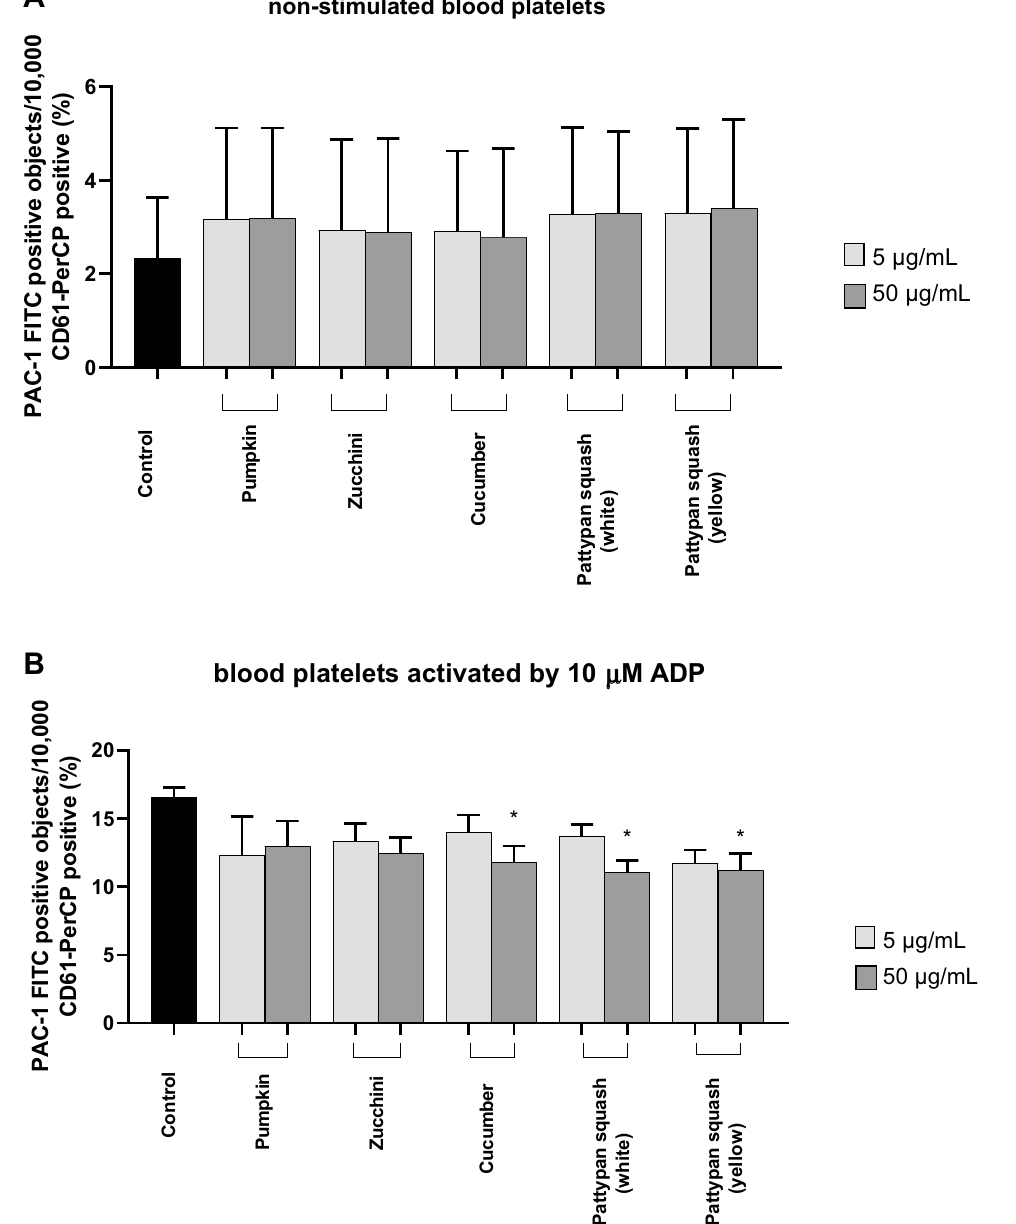
Figure 5. Effects of the five cucurbit vegetable preparations (concentrations 5 and 50 µg/mL, incubation time—30 min) on the expression of the active form of GPIIb/IIIa on resting ( A ) or agonist-stimulated blood platelets: 10 µM ADP ( B ), 20 µM ADP ( C ) and 10 µg/mL collagen ( D ) in whole blood samples. Additionally effects of three selected preparations (cucumber, pattypan squash white and yellow; 50 µg/mL; 30 min) on the expression of the active form of GPIIb/IIIa in platelets stimulated by 10 µM ADP in whole blood samples ( E ). This figure demonstrates selected diagrams ( E ). The blood platelets were distinguished based on the expression of CD61. For each sample, 10,000 CD61-positive objects (blood platelets) were acquired. For the assessment of GPIIb/IIIa expression, samples were labeled with fluorescently conjugated monoclonal antibody PAC-1/ FITC. Results are shown as the percentage of platelets binding PAC-1/FITC. Data represent the mean ± SD of six healthy volunteers (each experiment performed in triplicate). *p < 0.05 (vs. control platelets). There wasn’t any statistically significant between effect of 5 and 50 µg/mL (p >